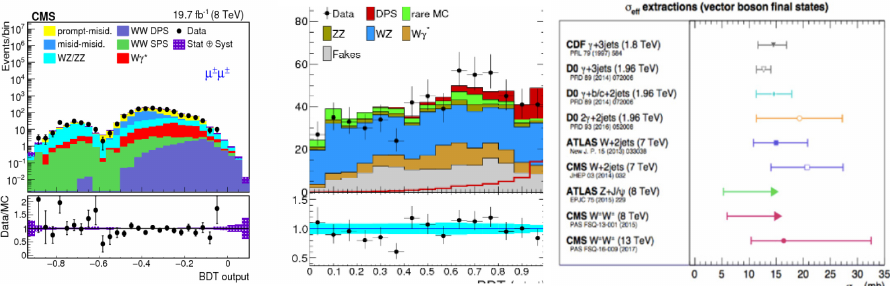
Fig. 7. Final BDT classifier output with all background estimations in place for (left) [9] and 13 TeV (middle) [10], Right: comparison of extracted previous experiments and CMS measurements